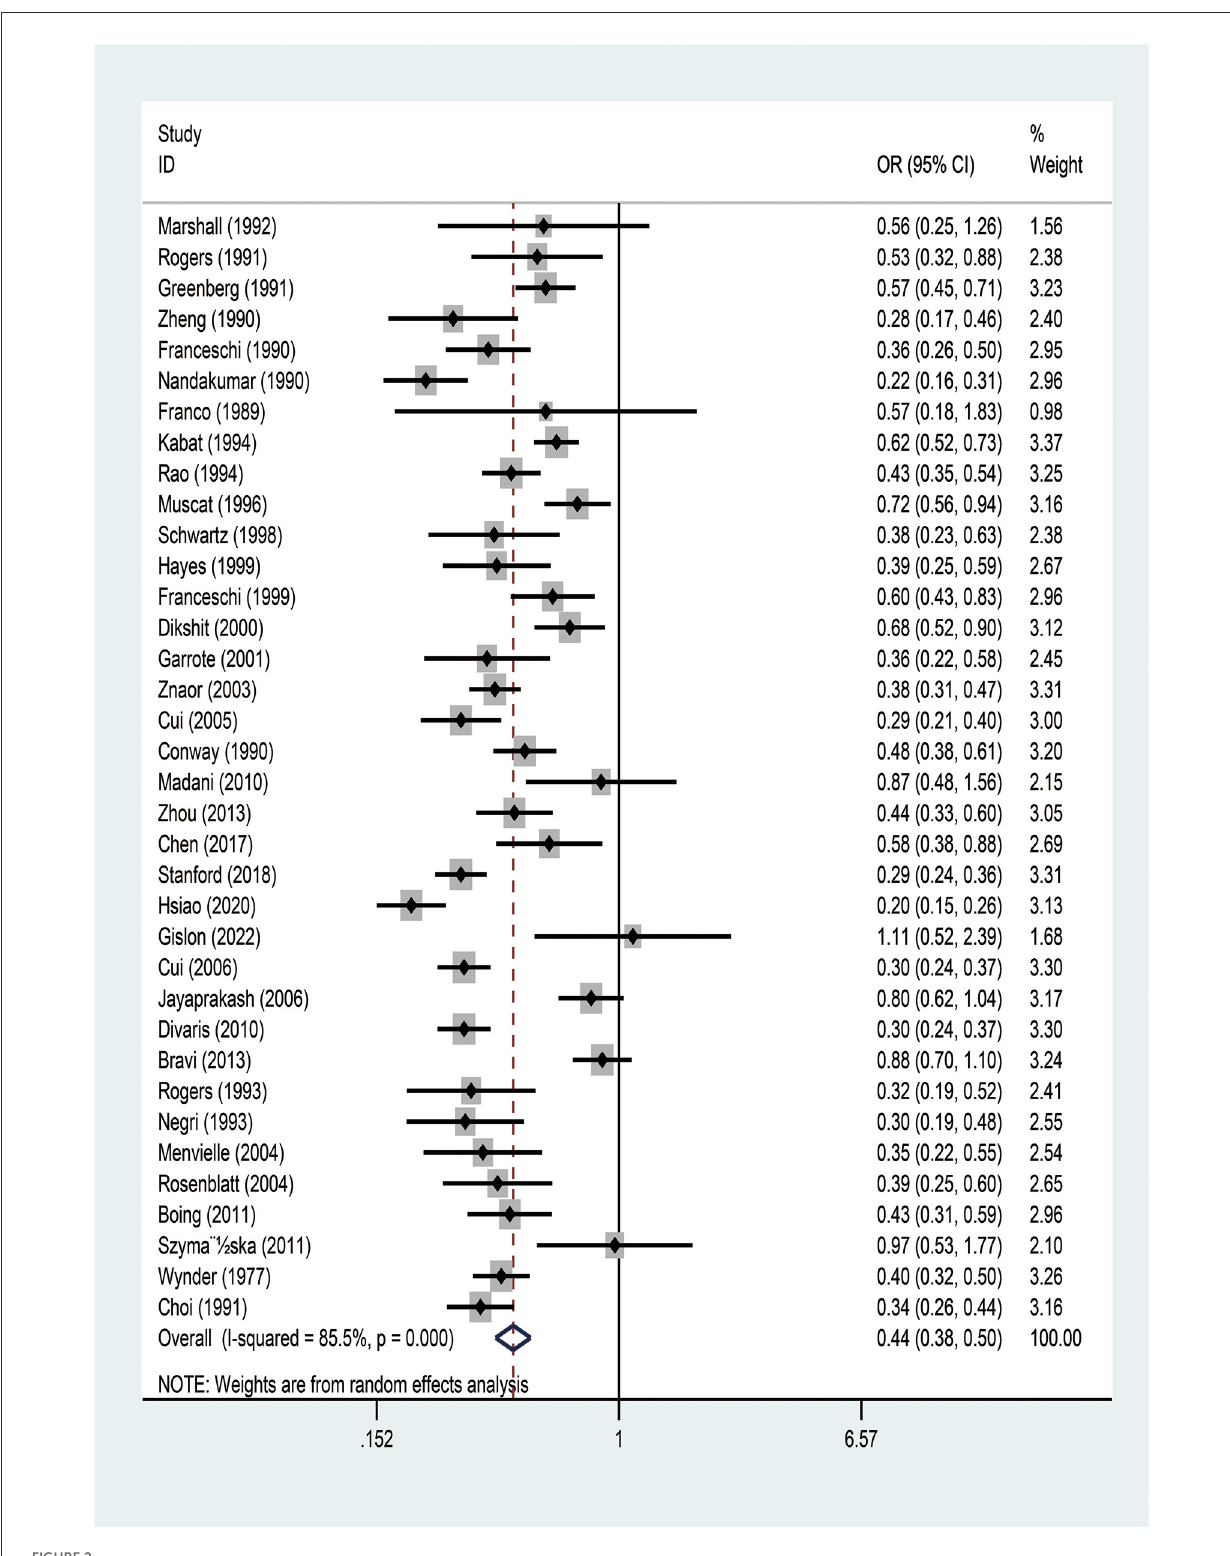
FIGURE2 Meta-analysis of studies on education and the risk of oral and oropharyngeal cancer using the random-effects model ordered by date of publication. OR, odds ratio; CI, confidence interval.